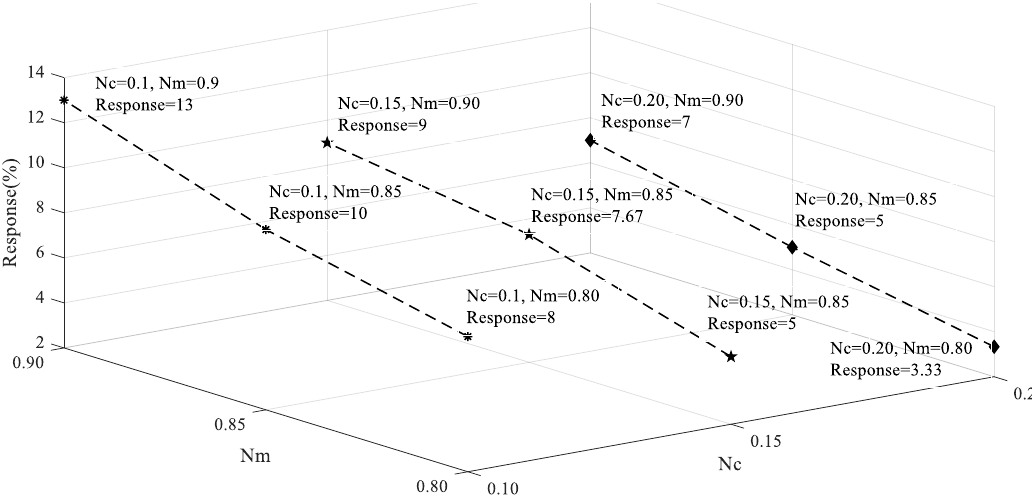
Figure 10. Response of Pareto ratio.